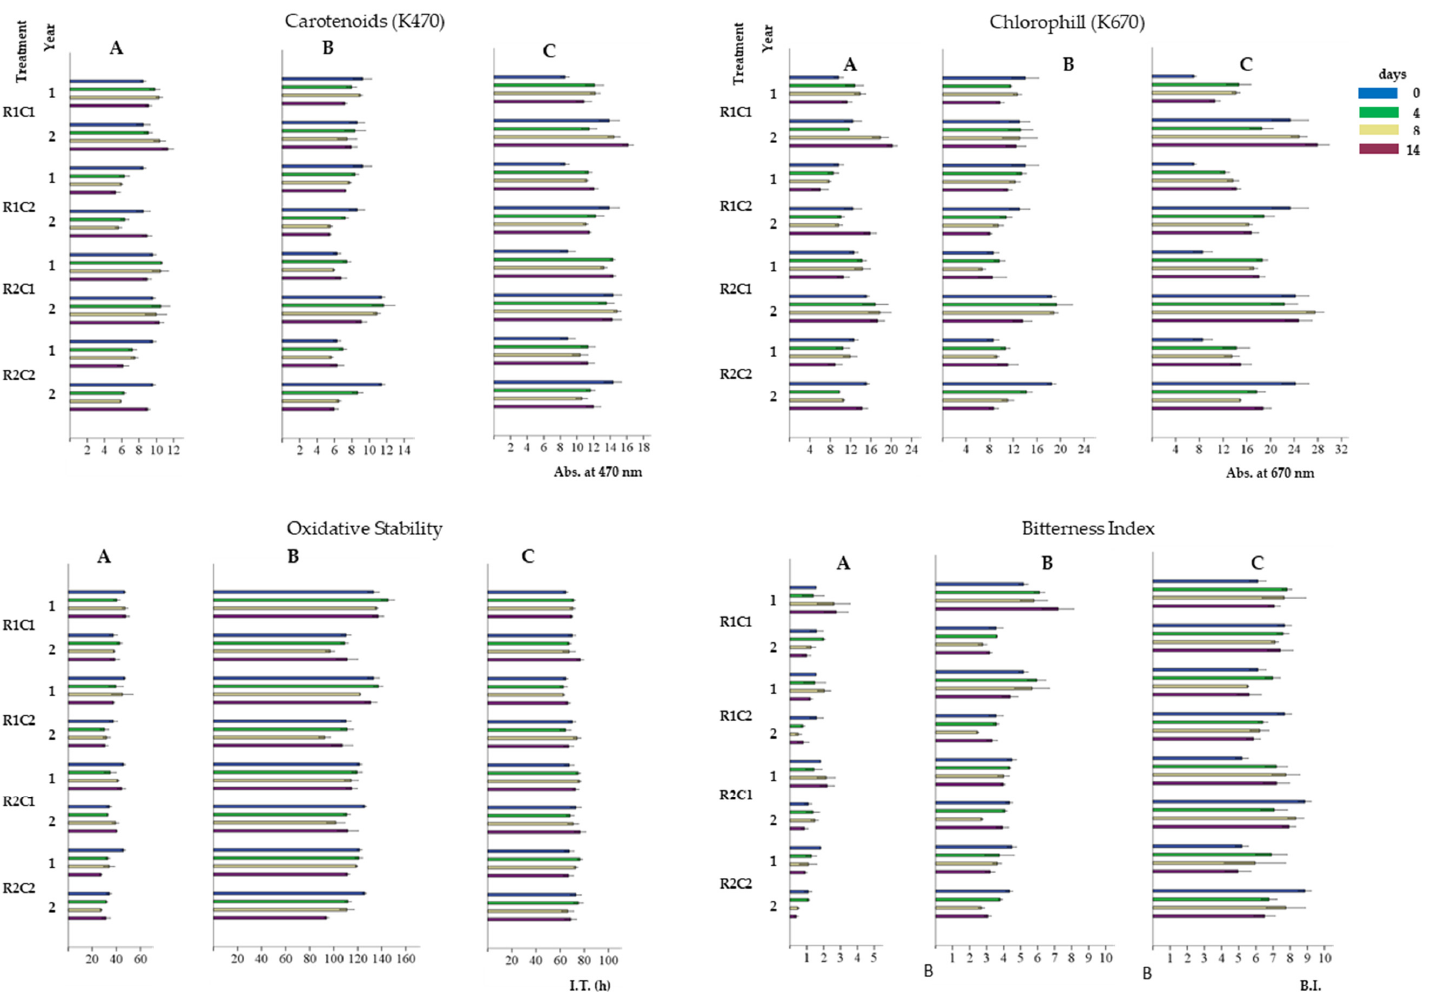
Figure 2. Carotenoids (K460), chlorophylls (K670), oxidative stability (h), and bitterness index, noted in the ‘Arbequina’ ( A ), ‘Picual’ ( B ), and ‘Verdial’ ( C ) olive oils extracted from fruit, picked with a Manual Inverted Umbrella (R1) and in a traditional way (R2) and stored for different days at 5 °C (C1) and ambient temperature (C2) during two consecutive years (year 1 and 2). Each bar is the mean ± SD of 3 replicates.